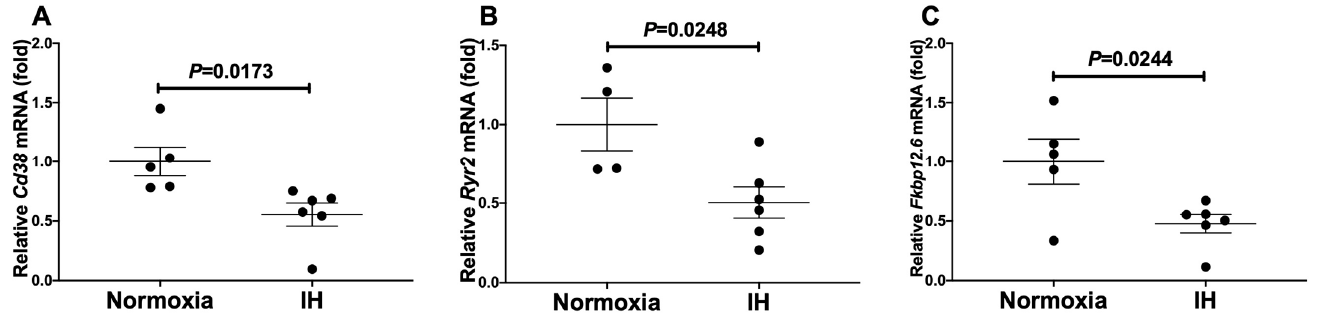
Figure 1. The mRNA levels of mouse ( A ) Cd38 , ( B ) Ryr2 , and ( C ) Fkbp12.6 in mouse P19.CL6 cardiomyocytes. Cardiomyocytic ‐ differentiated mouse P19.CL6 cells were treated with normoxia or IH for 24 h. The mRNA levels were measured by real ‐ time RT ‐ PCR and normalized by rat insulinoma gene (Rig)/ribosomal protein S15 (RpS15) as an internal standard. The mRNA level exposed to normoxia was set to 1.0. Data are expressed as the mean ± SE of the samples ( n = 4 to 6). Statistical analyses were performed using Student’s t ‐ test. IH significantly decreased the mRNA levels of Cd38 , Ryr2 , and Fkbp12.6 in mouse P19.CL6 cells. In addition, correlation analyses revealed that the correlation coefficient(s) between Cd38 vs. Ryr2 , Cd38 vs. Fkbp12.6 , and Ryr2 vs. Fkbp12.6 were 0.618, 0.912, and 0.566, respectively, indicating that there are positive correlation(s).